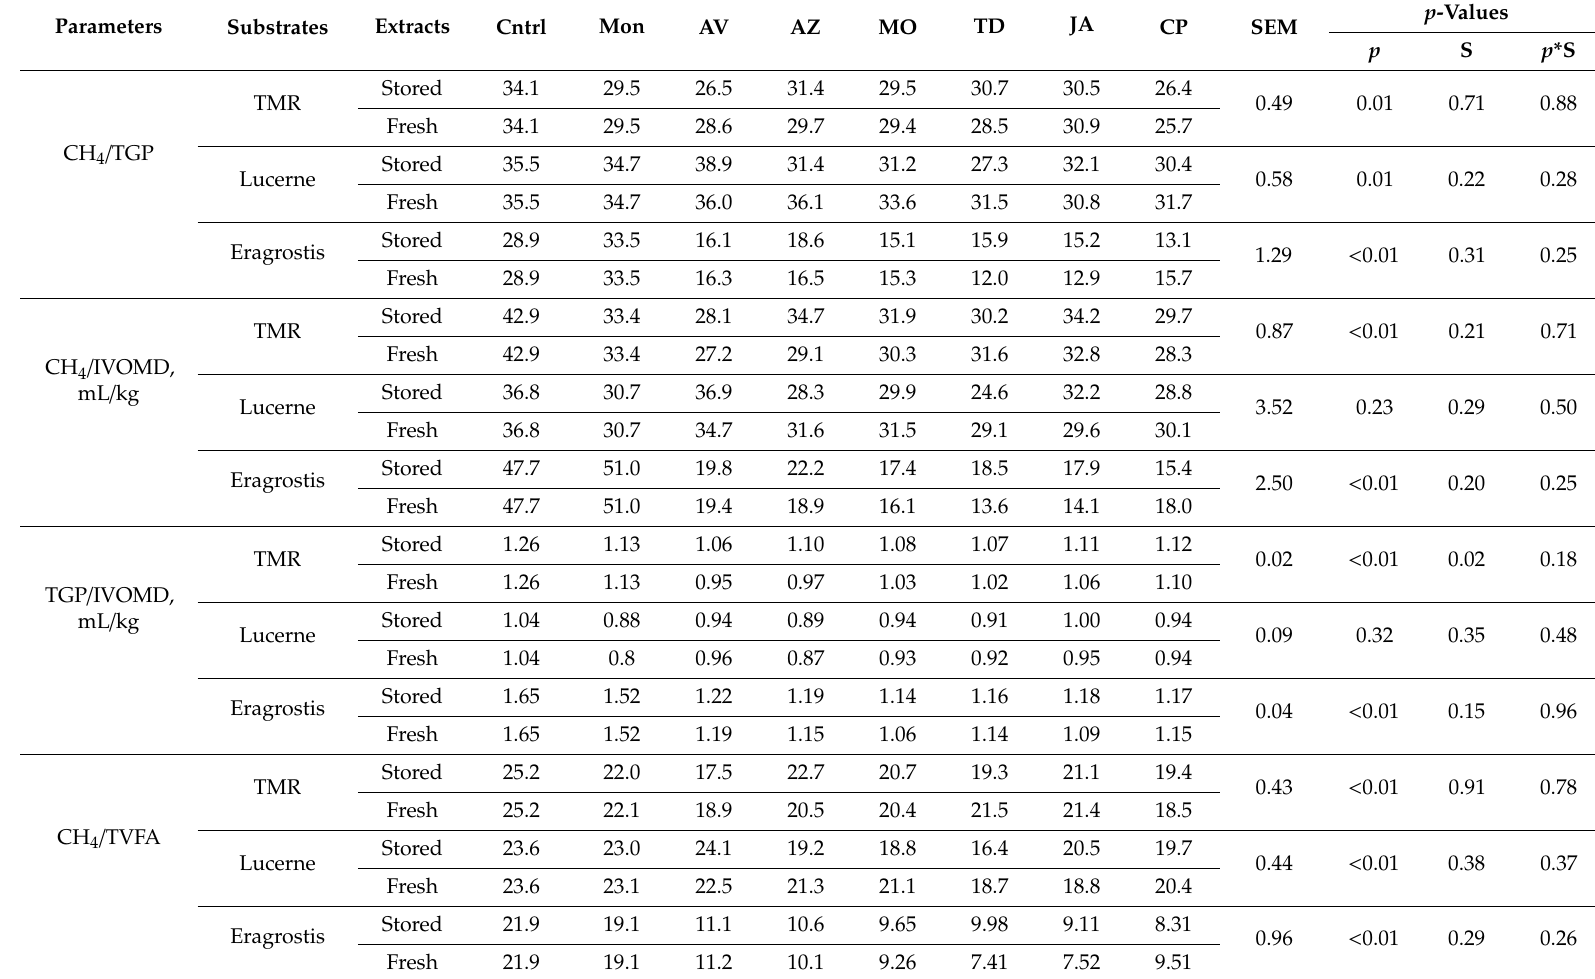
Table 3. The ratios of total gas production (TGP), methane (CH 4 ) and in vitro organic matter digestibility (IVOMD) from Eragrostis curvula , lucerne and TMR substrates incubated with stored or fresh plant